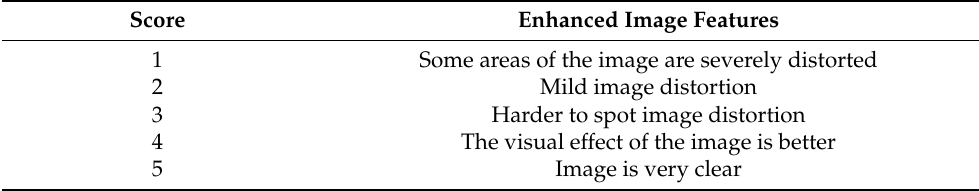
Table 4. Subjective evaluation score method.